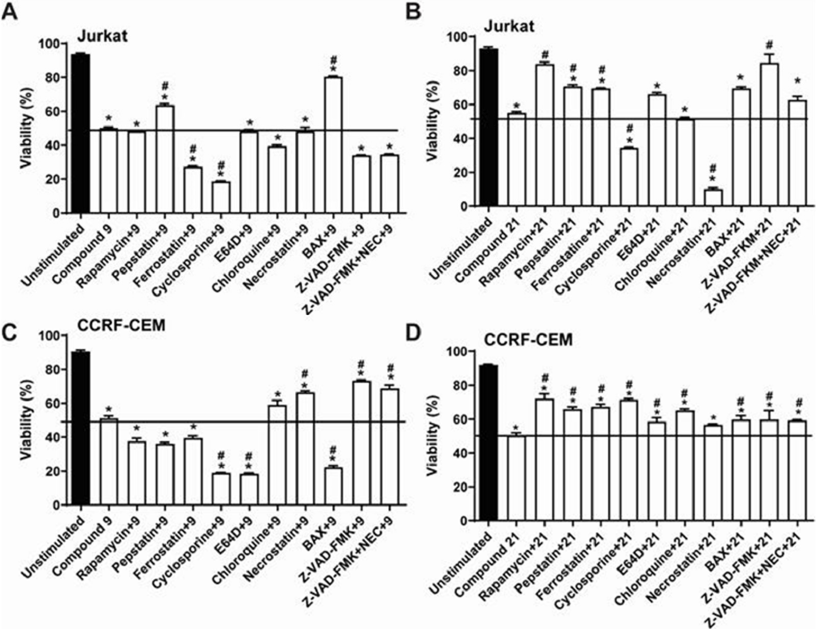
Figure 4. Evaluation of modulators of the pathways involved in the cell death process using specific inhibitors. Jurkat and CCRF ‐ CEM cells at 2 × 10 5 cells/mL were used. Cells were preincubated with the inhibitors for 1 h. Subsequently, cells were treated for 24 h with the respective EC 50 of the com ‐ pounds. Cytotoxicity was evaluated by flow cytometry with annexin V ‐ FITC/PI staining. These re